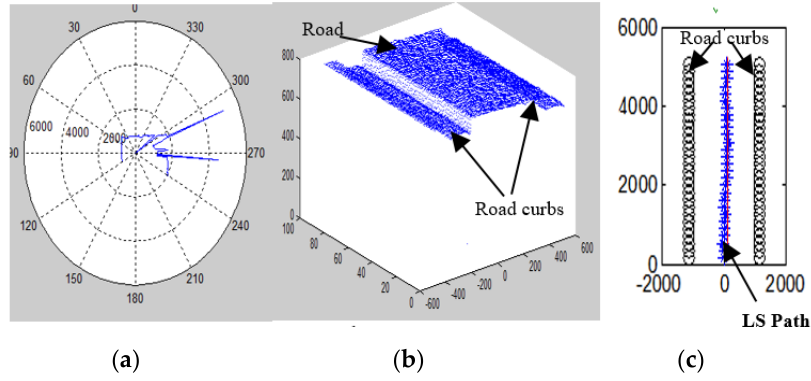
Figure 11. Principle of LRF measurement and calculation: ( a ) one scan measurement (mm), ( b ) road with curbs in 3D (mm), and ( c ) LS path generation (mm).